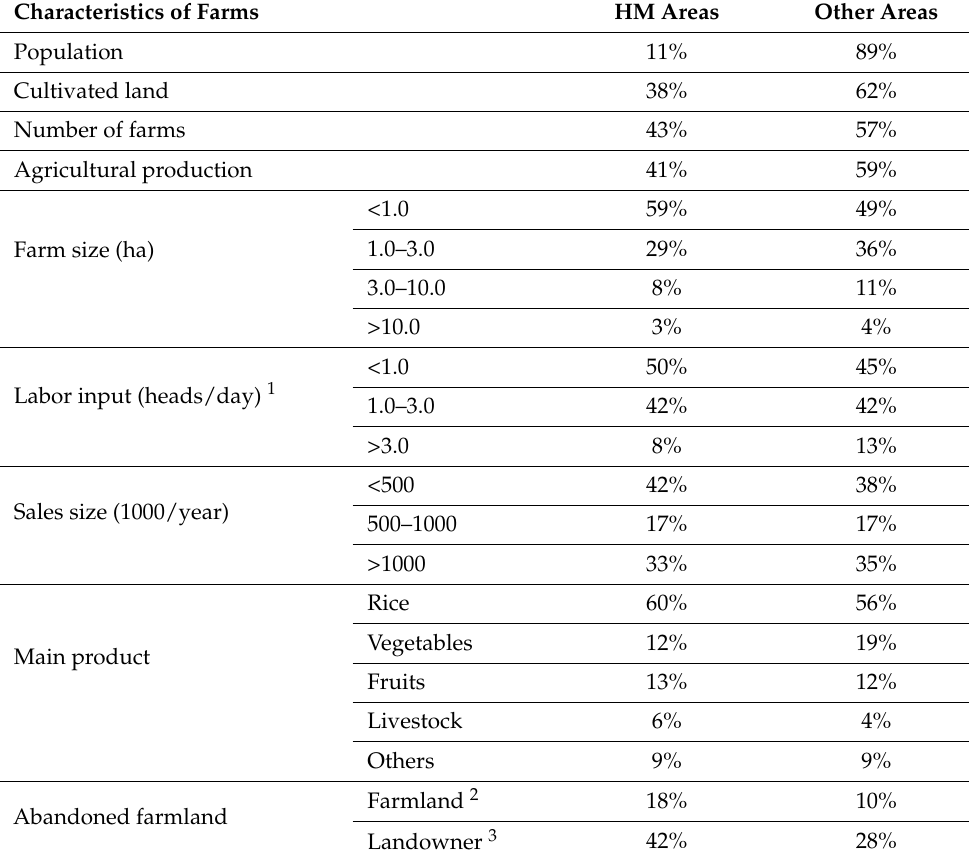
Table 1. Summary of HM areas and characteristics of farms in HM areas. Characteristics of Farms HM